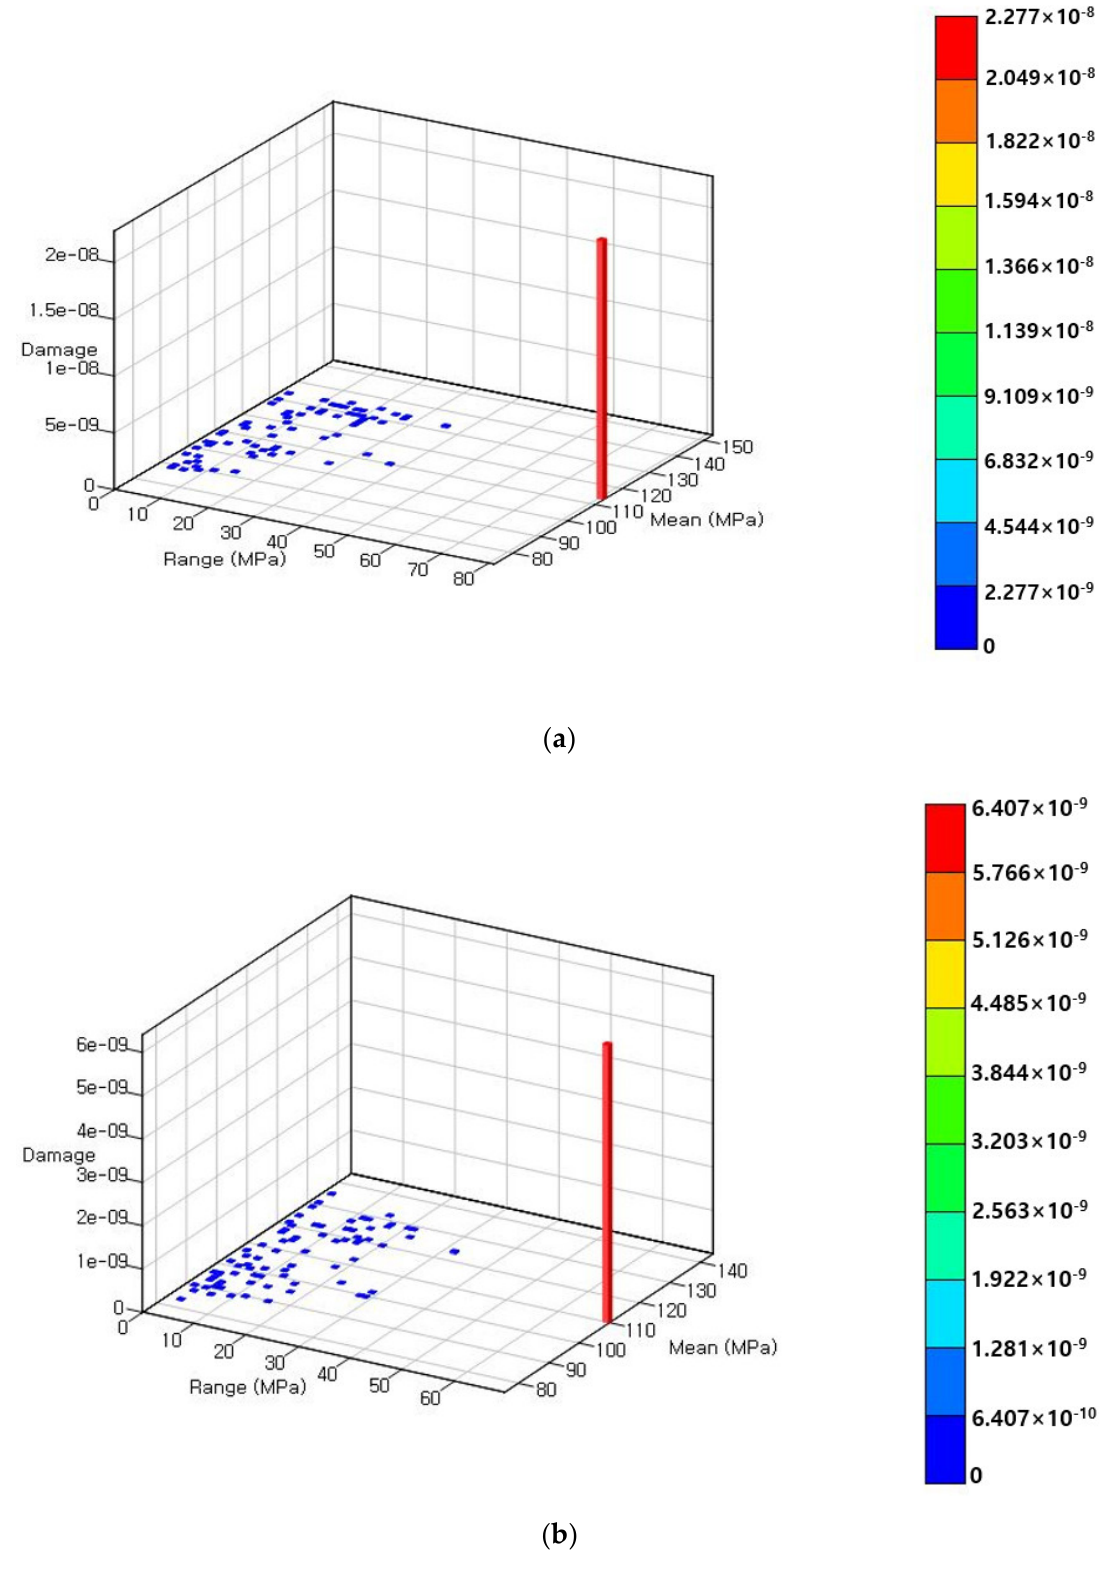
Figure 14. The shape of damage histogram when loading part is not lifted: ( a ) fastening device 1; ( b ) fastening device 2. Table 5. Maximum damage condition at each fastening device when loading part is lifted.